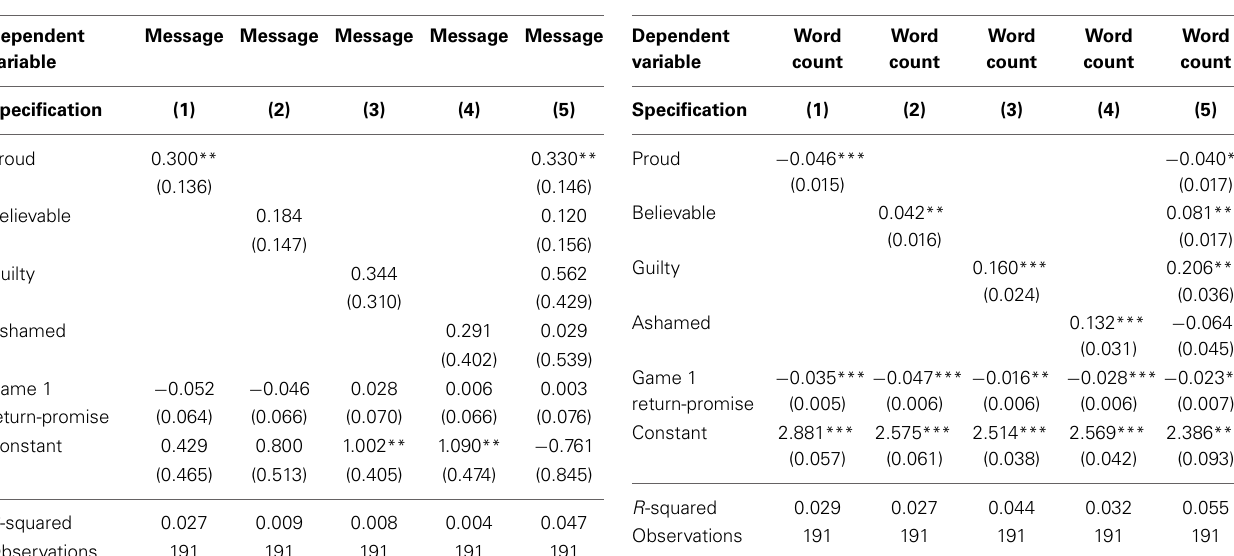
Table 5 | Regression of message on trustees’ emotions. Table 6 | Regression of word count on trustees’